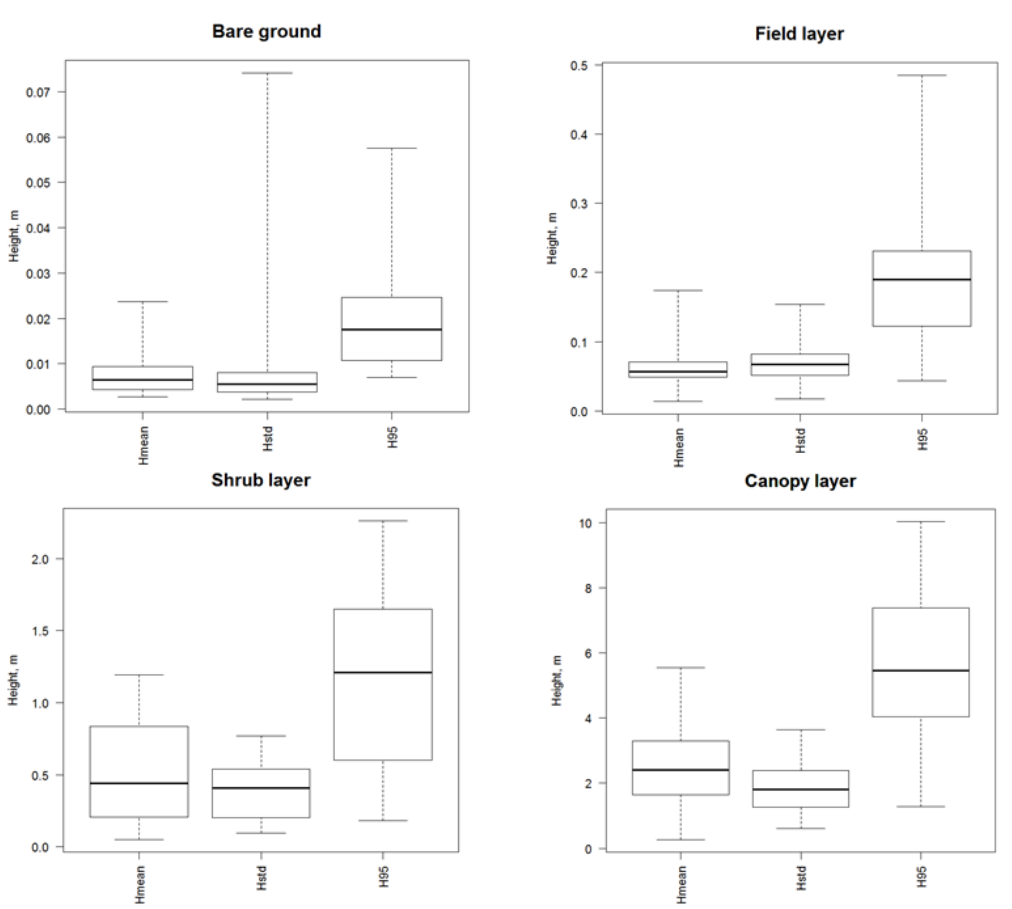
Figure 4. Variations of H collected in 2012).